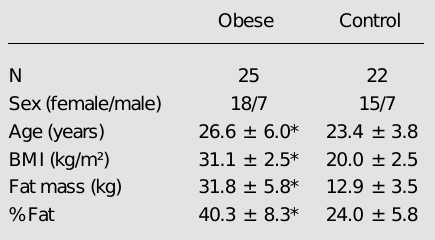
Table 1 - Clinical and anthropometric